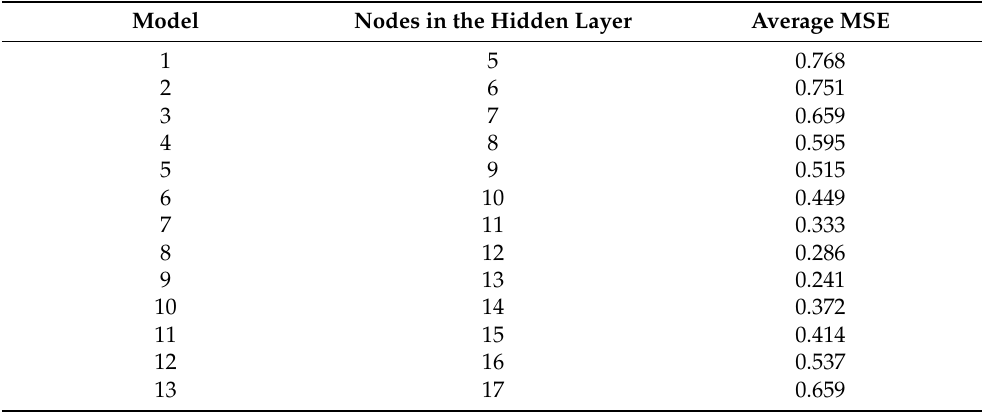
Table 4. Neural network structure and prediction